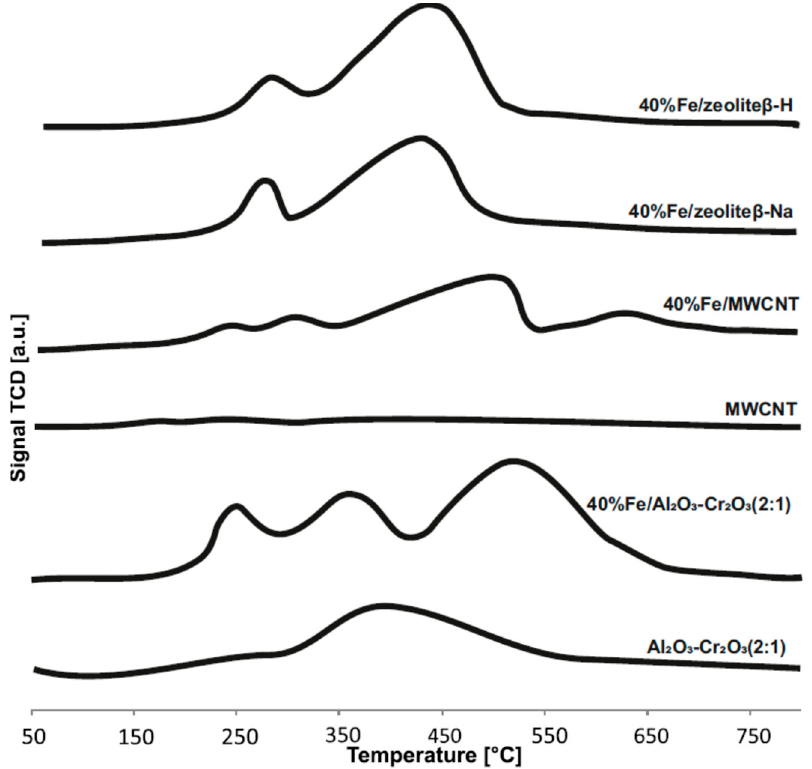
Figure 4. The temperature programmed reduction of hydrogen (TPR-H 2 ) curves of supports and iron